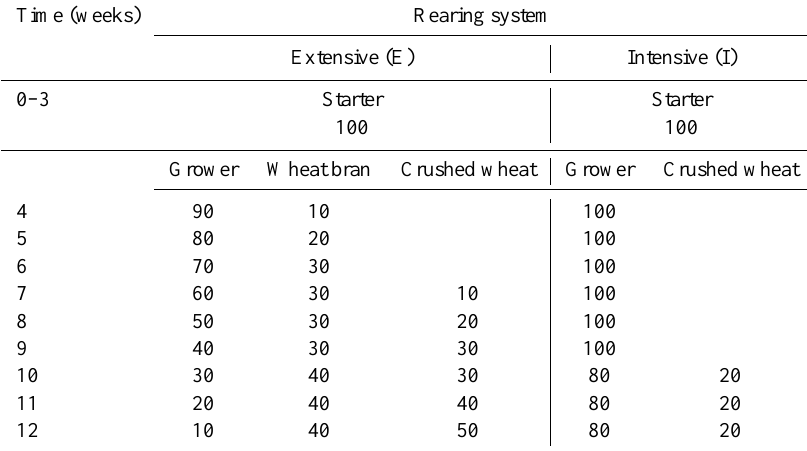
Table 2. Feeding regimen across feeding systems and age (percentage proportion of meals).